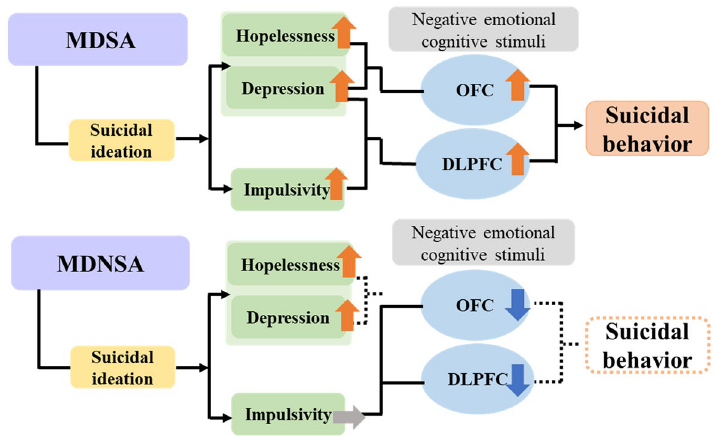
Figure 4. A model of frontal activity in mood disorders, including personality traits and SRB. We have modified the figure of Mann et al. 4 based on our